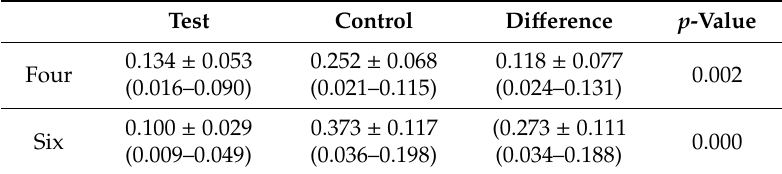
Table 1. Mean angular deviation between groups. Data are presented in degrees ( ◦ ) as the mean ± SD (95%